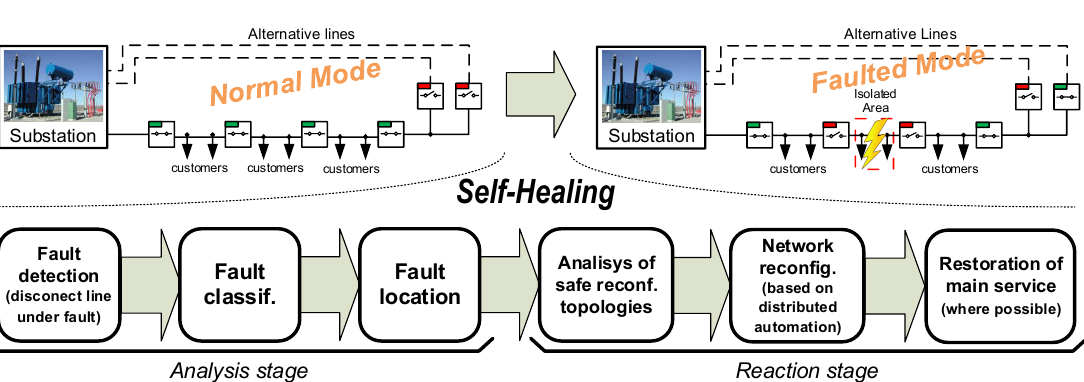
Figure 1. Brief description of the self-healing